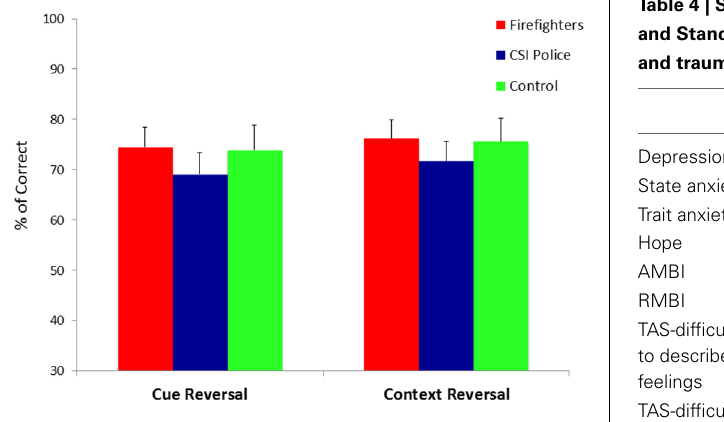
FIGURE 4 | Percentage of correct responses in the reversal phase as a function of Reversal Type (cue vs. context), and experimental group (trauma exposed firefighters, trauma exposed CSI police and trauma-unexposed controls) in positive to negative trials.